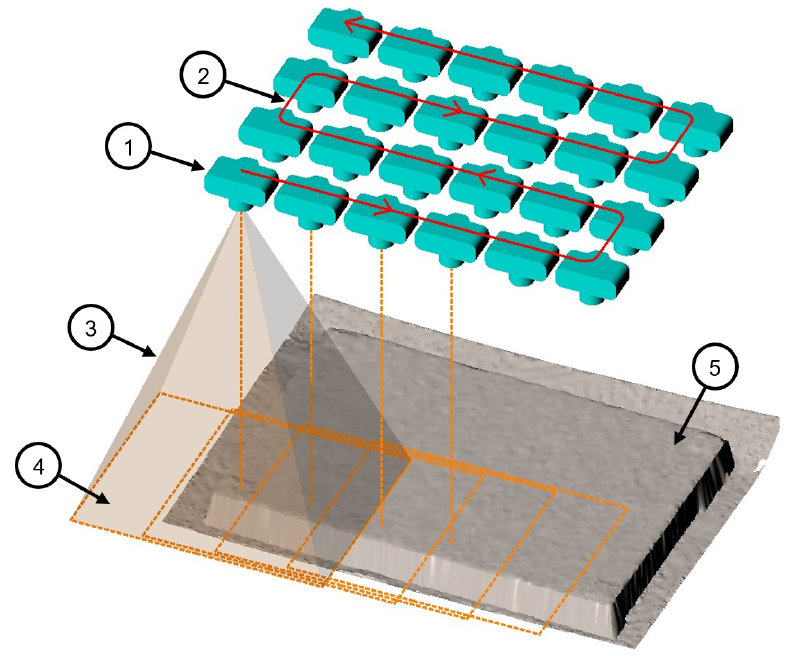
Figure 5. Concept of the recording geometry. 1—camera position; 2—camera trajectory; 3—field of view pyramid; 4—imaging area; 5—concrete surface.